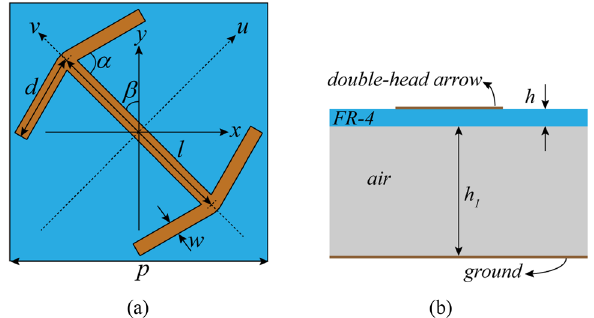
Figure 1. Schematic of basic unit-cell ( a ) top view ( b ) side